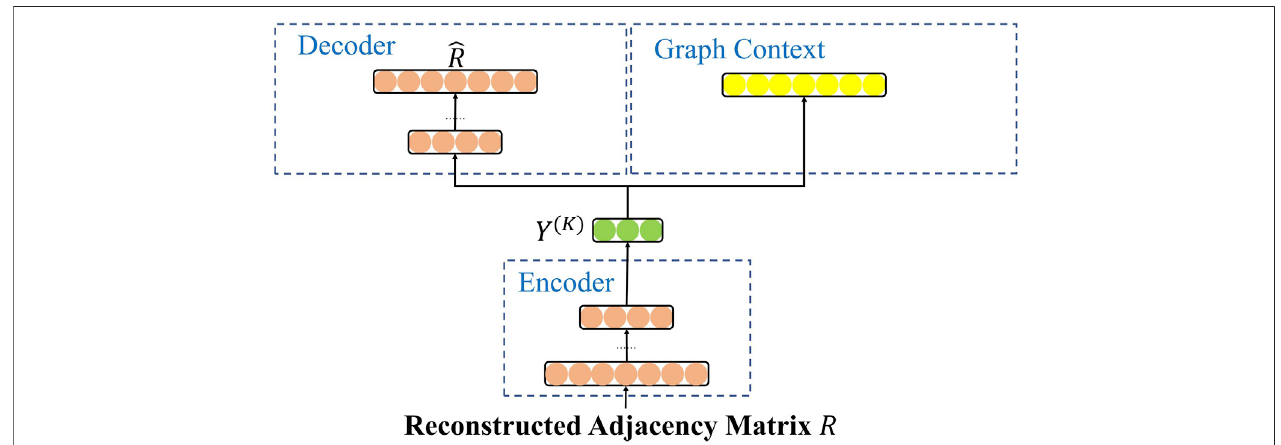
FIGURE 1 | The architecture of the proposed DANRL-CA